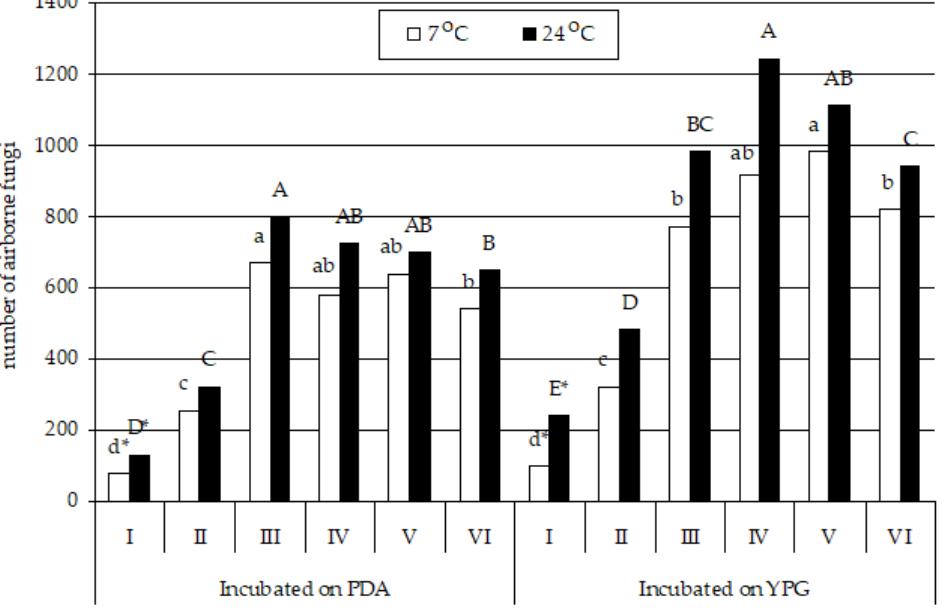
Figure 4. The number (CFU per 1 m 3 ) of airborne fungi cultured on PDA or YPG and incubated at 7 or 24 ± 0.5 ◦ C in the underground hibernation sites in the Nietoperek bat reserve. Study site number I was outside the underground object and locations from II to VI inside it. The air sampler was positioned 1.5 m above the level of the floor in study site numbers from I to III, and it was positioned at a distance of 0.7 to 1 m from clusters of M. myotis in locations from IV to VI. * For each location, the number of fungal spores followed by the same letter are not statistically different, and others are (Tukey’s HSD test, α ≤ 0.05). Letters indicate the differences between fungal species in a given location: small letters for 7 ± 0.5 ◦ C and capital letters for 24 ± 0.5 ◦ C; the analyses was carried out separately for PDA and